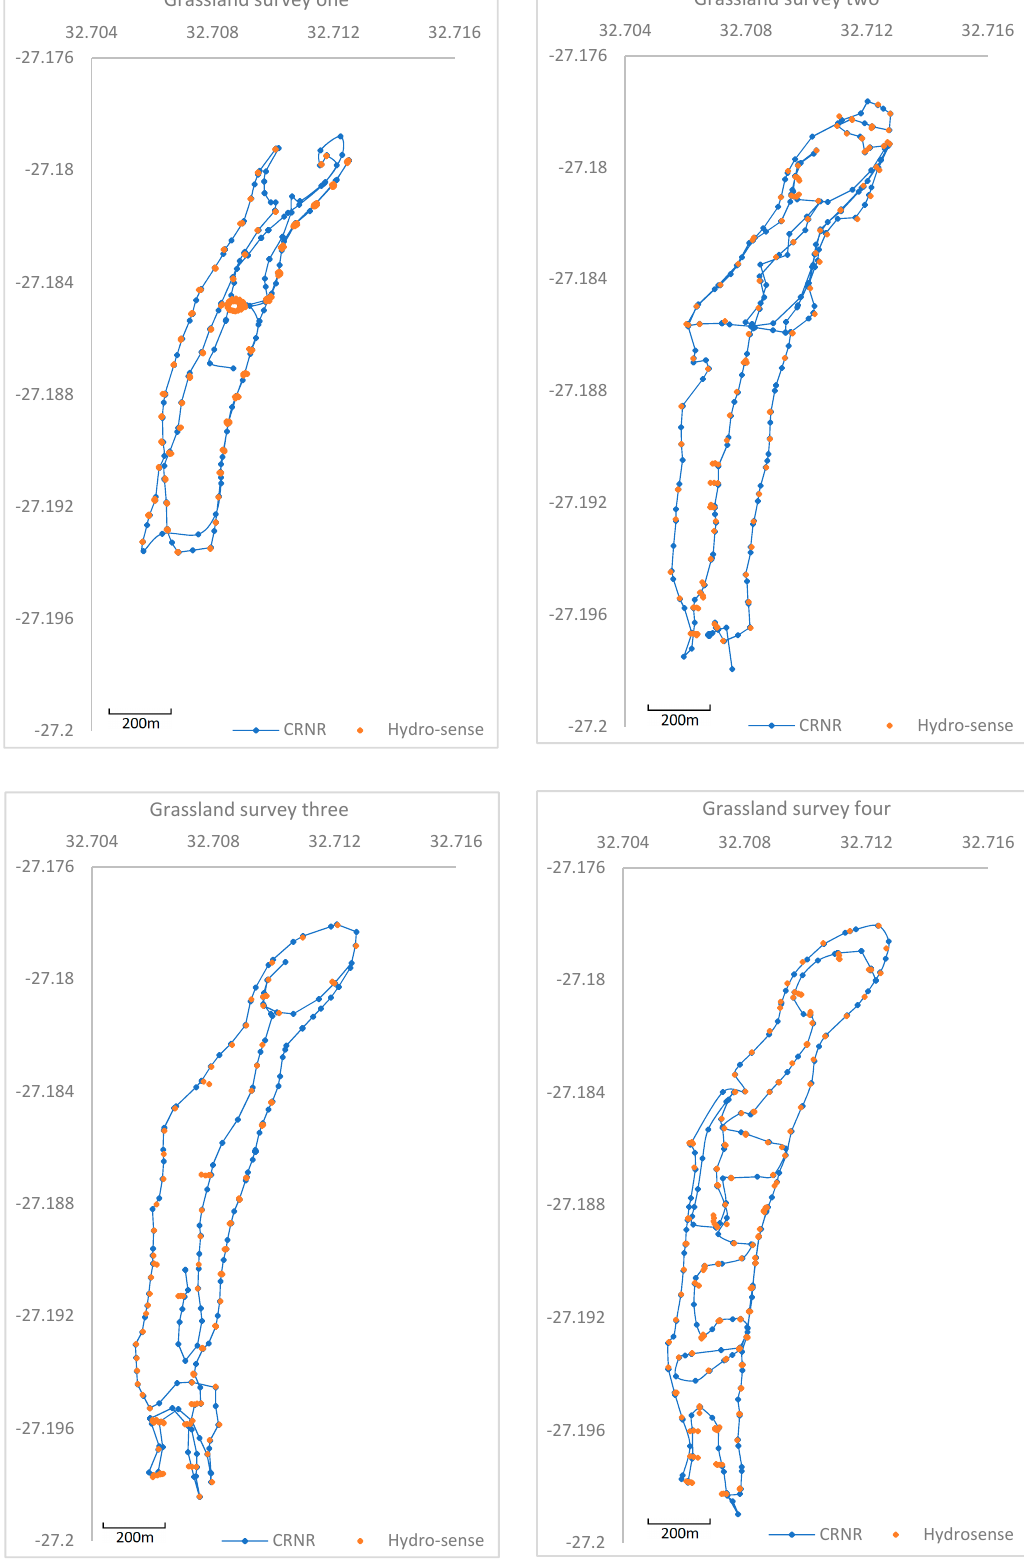
Figure 3. Cosmic Ray Neutron Rover (CRNR) paths and hydro-sense points of hygrophilous grassland